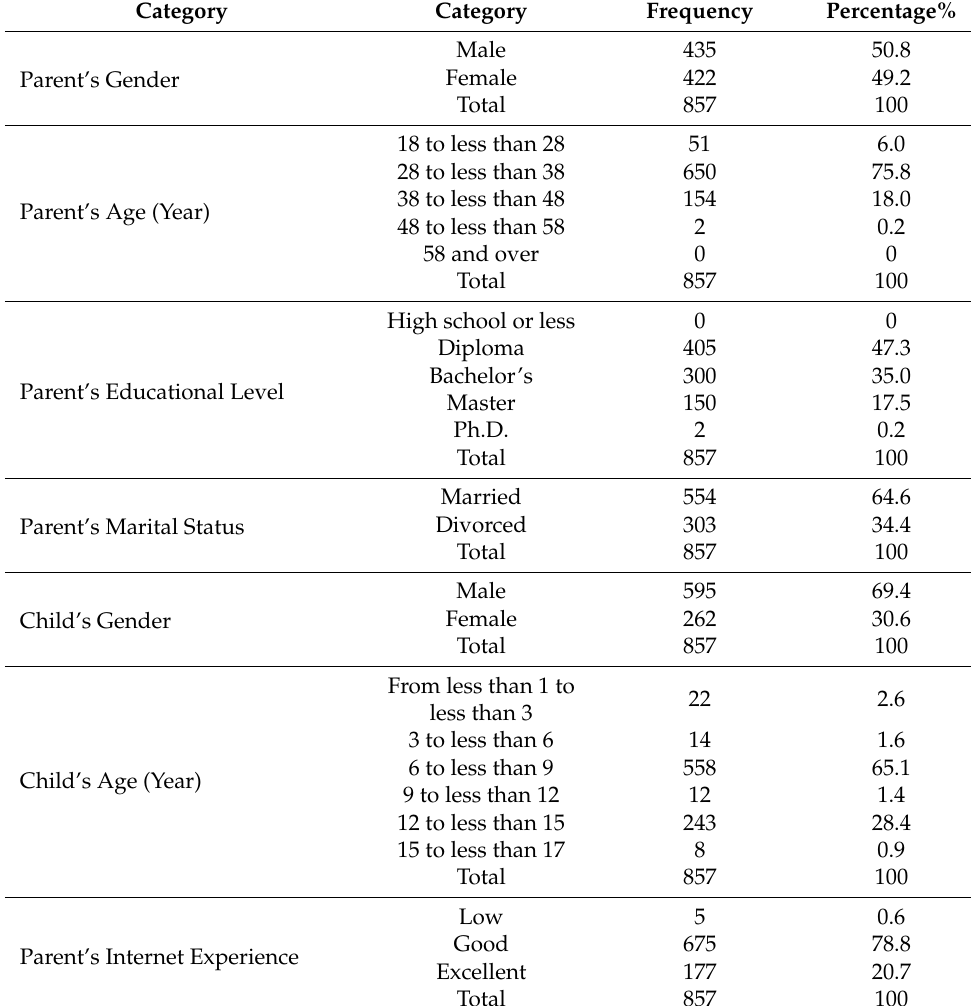
Table 2. Description of the respondents’ demographic